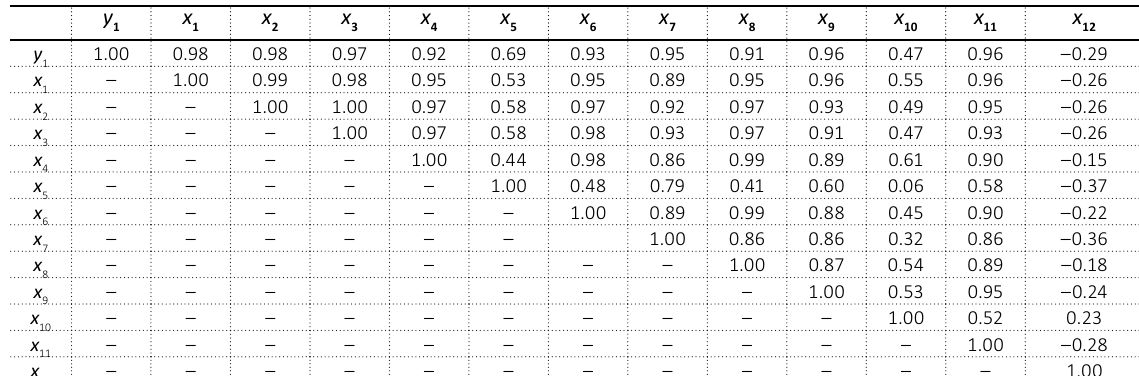
Table 4. Correlation matrix of dependence between